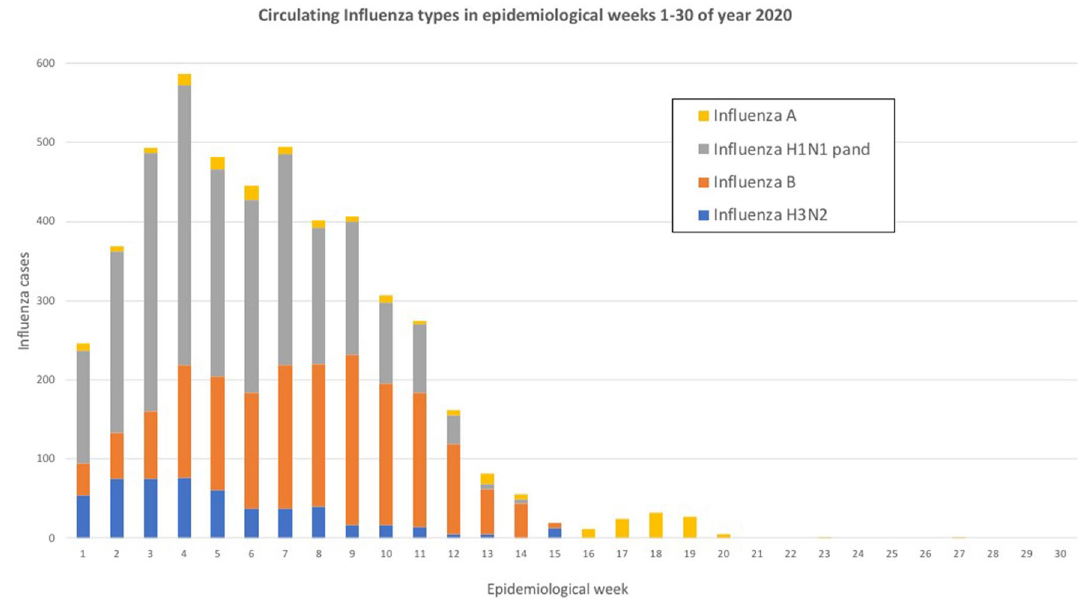
Figure 3. Circulating Influenza types in EPI weeks 1–30 of year